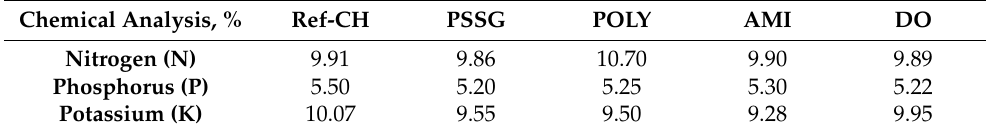
Table 1. Nutrient content in tested composite fertilizers.